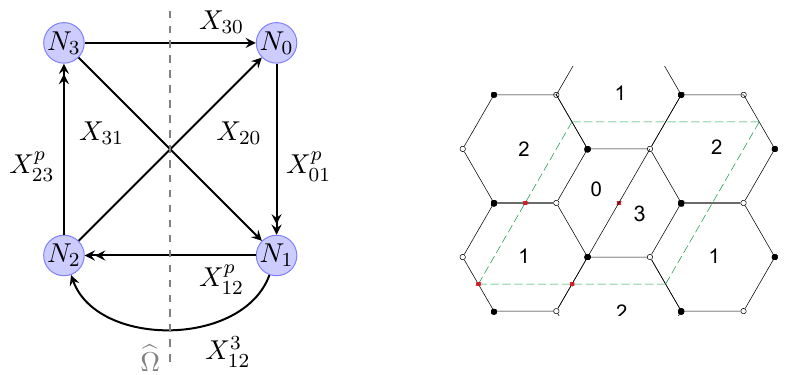
Figure 13. The orientifold projection b (cid:10) of dP 1 , whose quiver is on the left and dimer on the right.